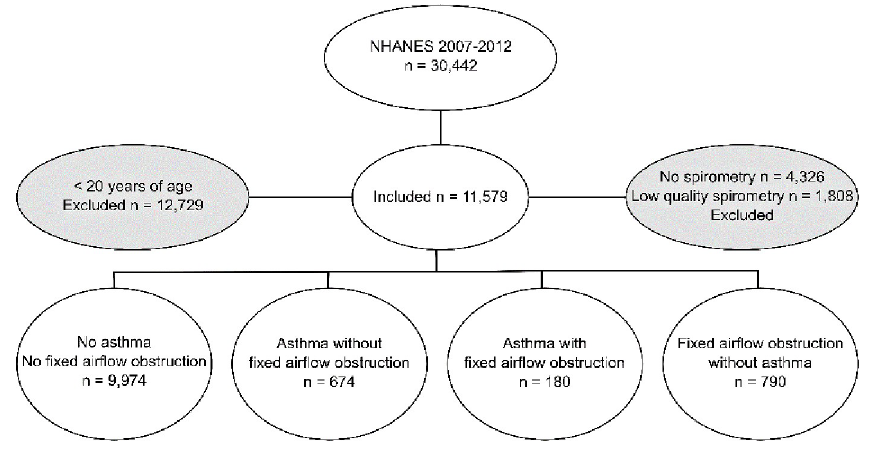
Fig 1. Flow-chart of included